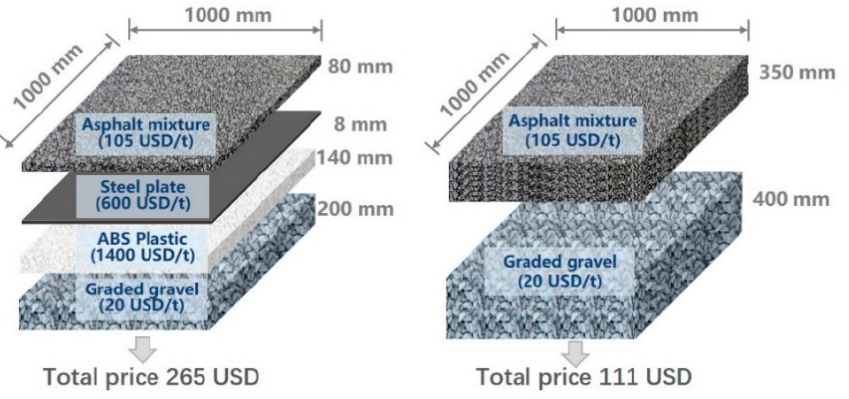
Figure 18. Comparison of cost for ASP and a traditional pavement structure. Table 9 compares the ASP pavement with traditional pavement indicating its advan- tages in efficiency, durability and environmental footprint. Table 9. Comparison between ASP pavement and traditional pavement. Contrastive Terms ASP Pavement